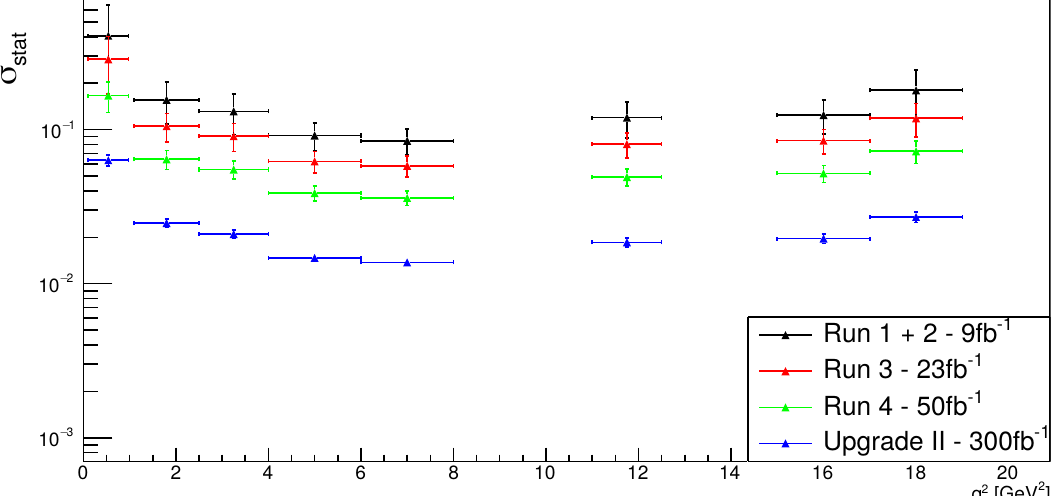
Figure 18 . The expected statistical uncertainty of the observable M 2 as a function of q 2 for various future integrated